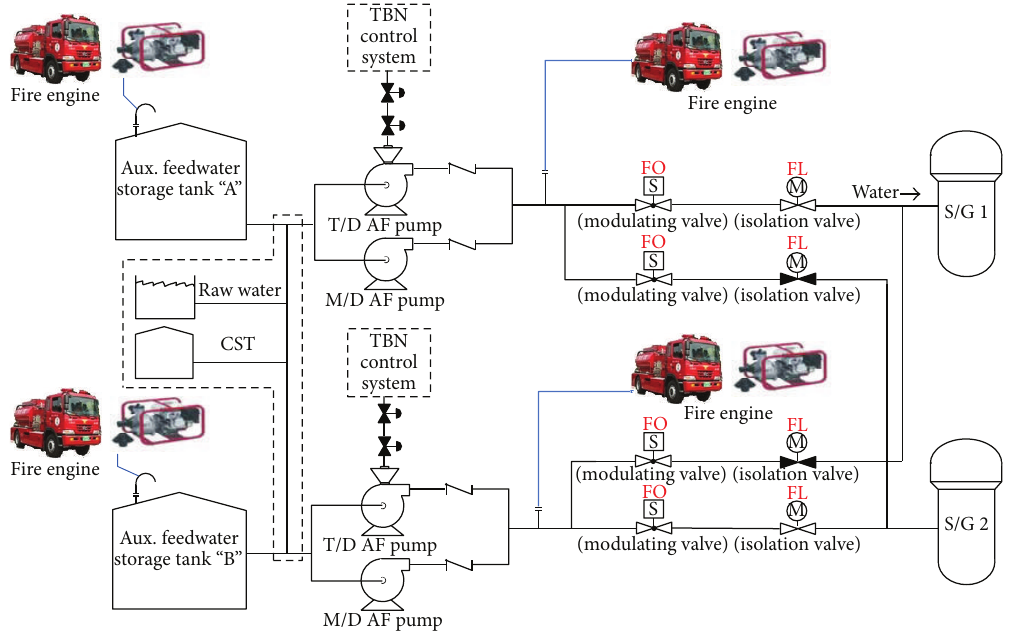
Figure 2: Schematics of SG external